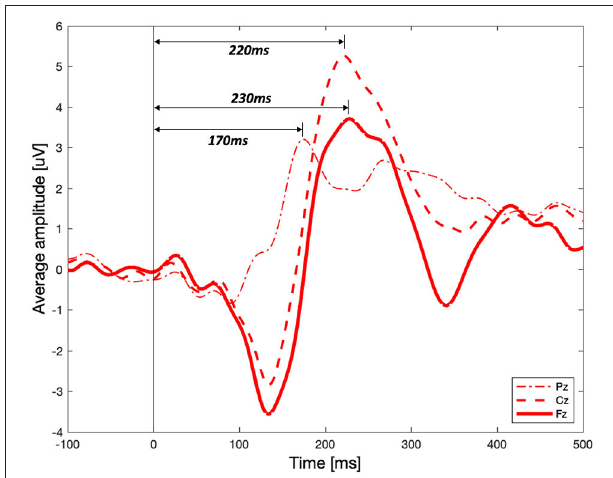
FIGURE 9 | Event-related potential for the high-intensity vibration in the middle parietal (Pz), central (Cz), and frontal (Fz)